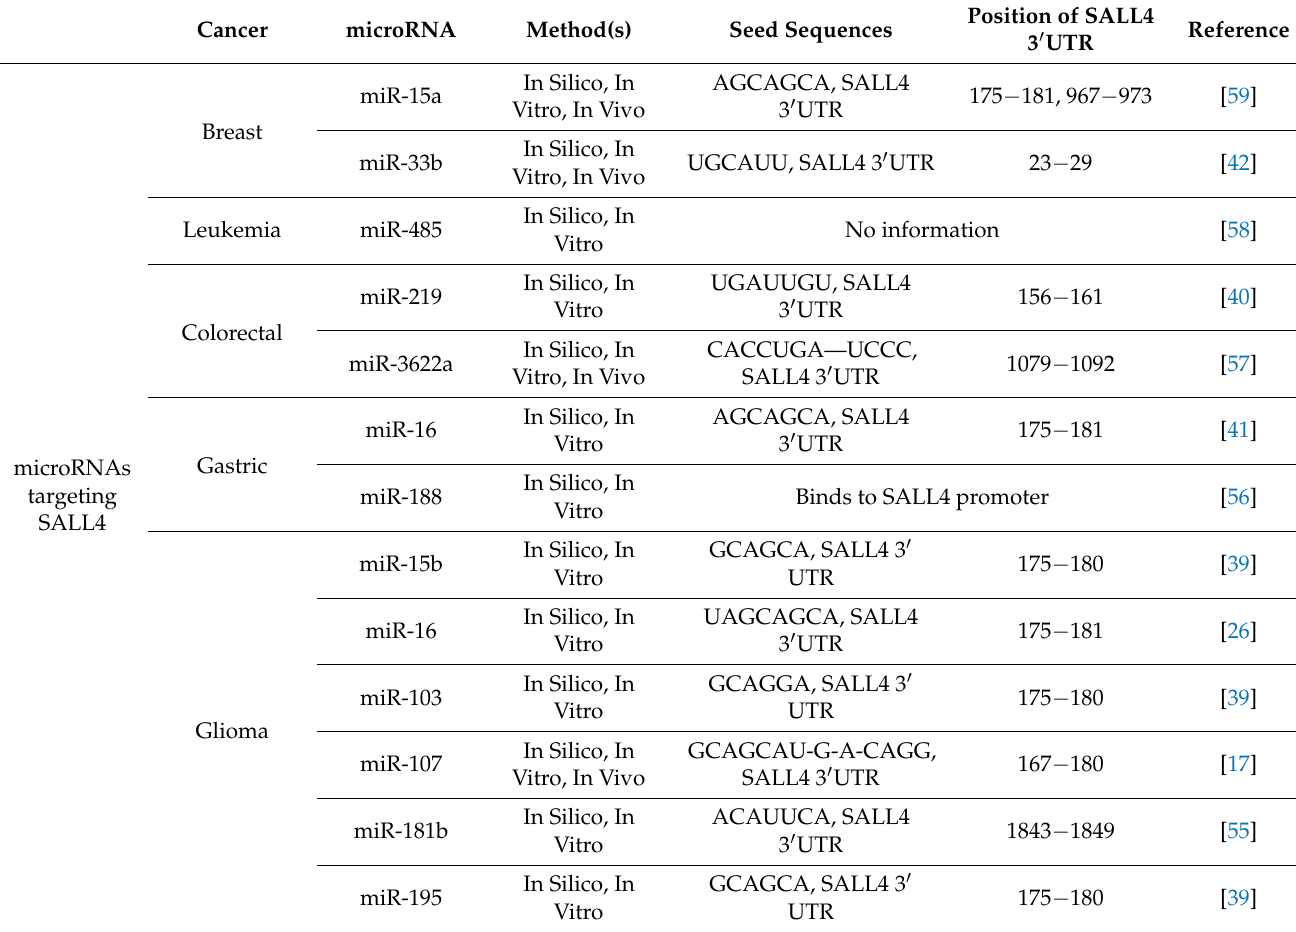
Table 1. Summary of all microRNAs known to regulate SALL4 and are regulated by SALL4.